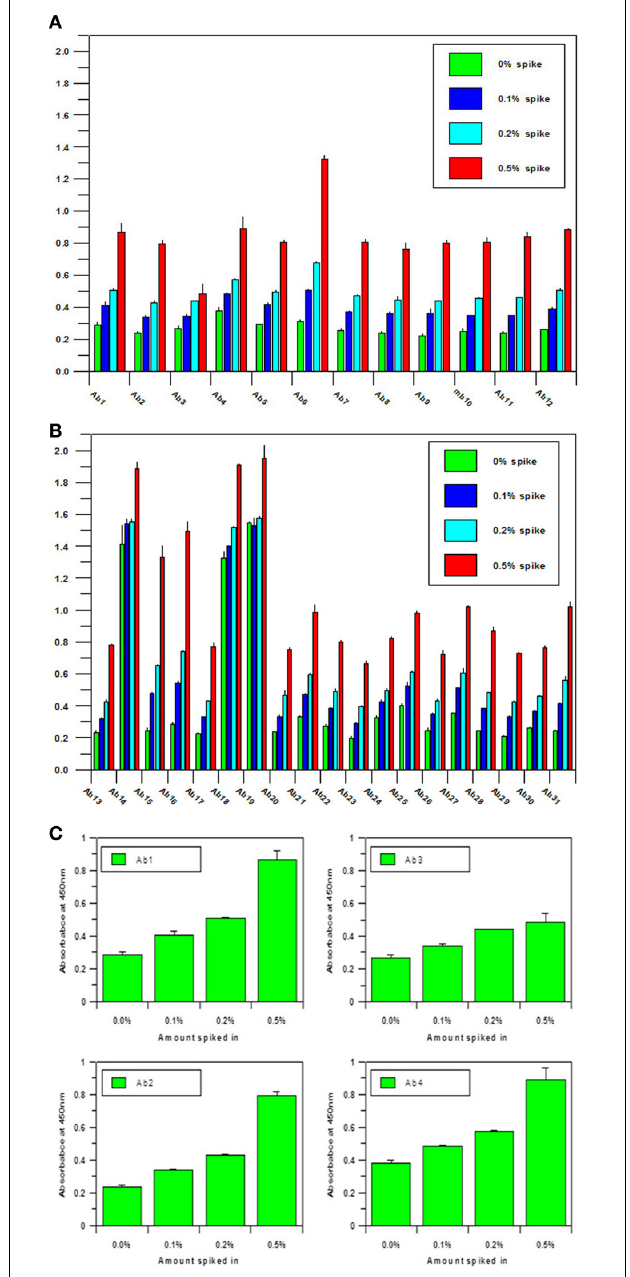
FIGURE 2 | (A) Sensitivity of the antibody array ELISA for mAb surface epitope exposure in the variable region.A monoclonal antibody under clinical developmentwas treated with 8M urea and spiked into the same native mAb at 0, 0.1, 0.2, and 0.5%, respectively. Sandwich ELISA was used to measure the surface epitope exposure of each mAb samples. A final mAb concentration of 5 μ g/ml was used for the analysis. (B) Sensitivity of the antibody array ELISA for mAb surface epitope exposure in the constant region. Same conditions as in (A) were used for the testing except the antibodies tested were against the constant regions of the mAb. (C) Quantitation of Epitope Exposure using the Antibody Array ELISA Standard Curve. For the quantitative measurementof surface epitope exposure in different regions of the mAb, a standard curve could be generated with the different levels of unfolded mAb induced from 8m urea treatment.